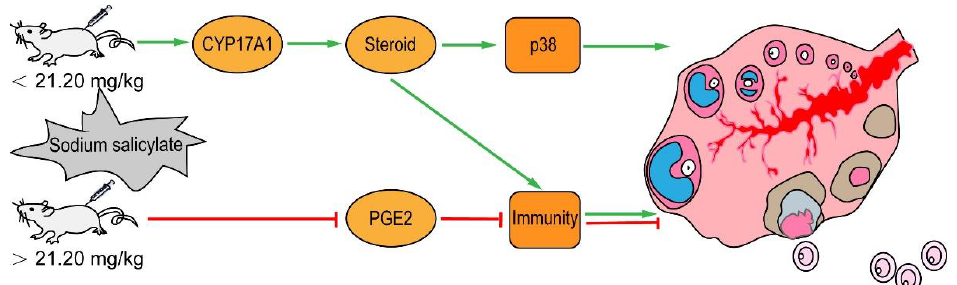
Figure 7. Low-dose sodium salicylate regulates the increase in endosterol and PGE2 through CYP17A1 and ultimately activates the p38 signaling pathway to promote ovulation. Ovulation, shown in green, is promoted by low-dose sodium salicylate injection. Ovulation, shown in red, is inhibited by high-dose sodium salicylate injection.